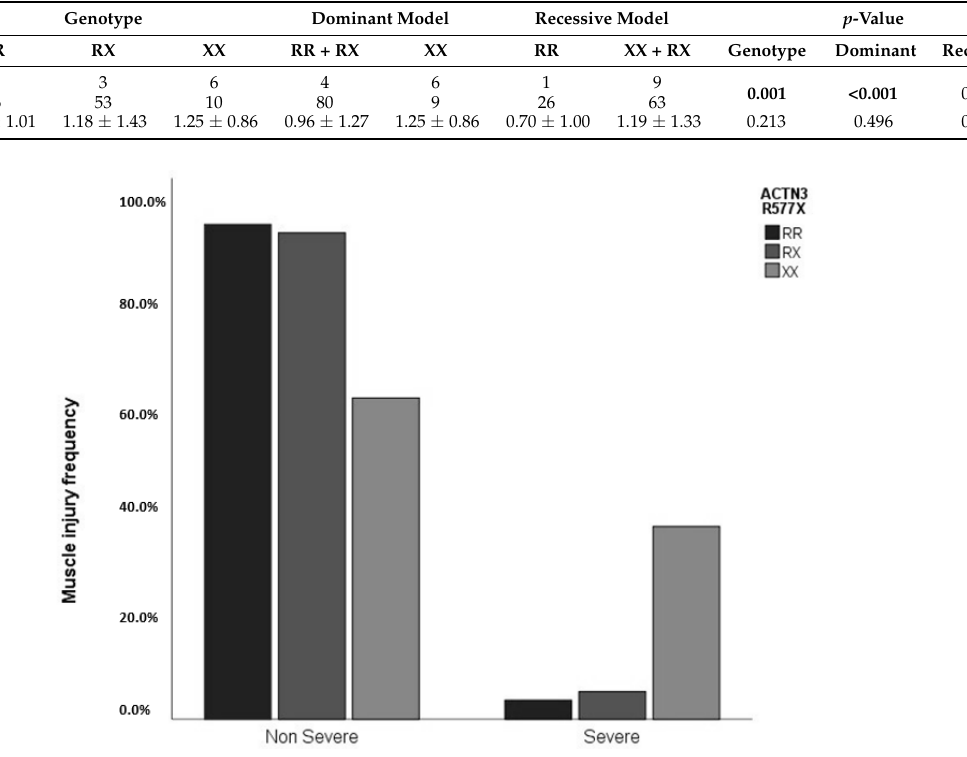
Figure 1. Distribution of severe and non-severe muscle injuries according to the ACTN3 R577X genotypes ( p = 0.001).